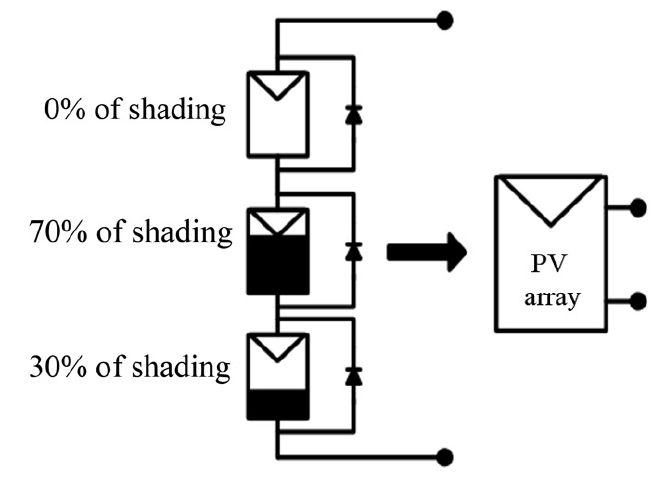
Figure 6. Representation of partial shading application in Simulation Step